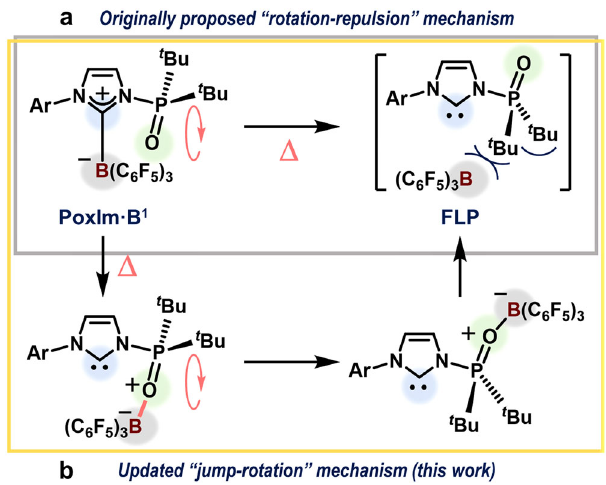
Fig. 1 Revival of FLPs from PoxIm·B 1 adducts, induced by thermally responsive molecular motions. a A previously proposed mechanism. b The updated mechanism proposed based on the results of this